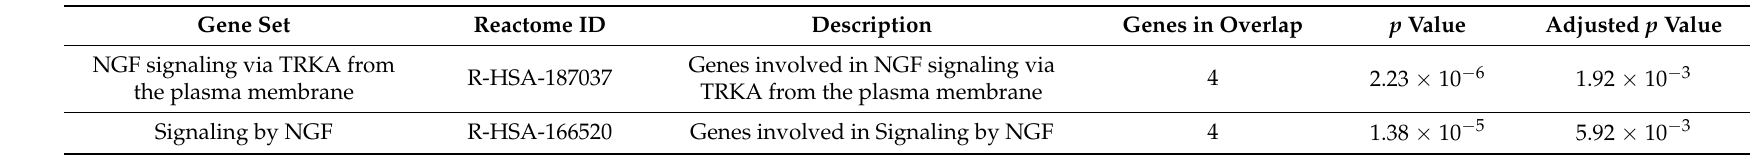
Table 5. Results from the Gene Set Enrichment Analysis (GSEA) based on Reactome